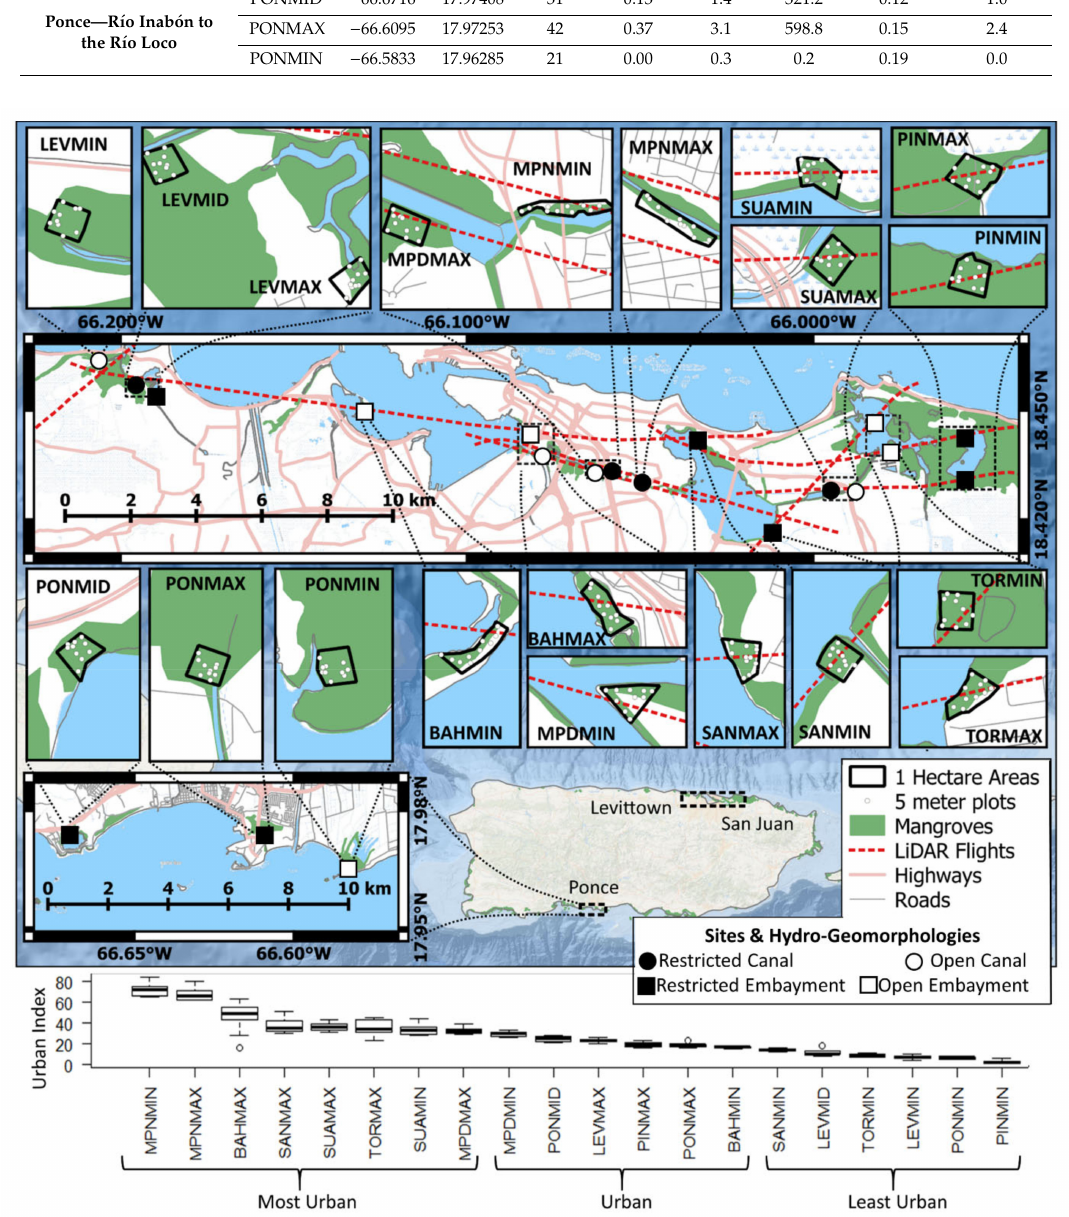
Figure 1. Study sites are twenty 1-hectare mangrove forests in three watersheds (top) and spanning a gradient of urbanization as measured by the urban index (bottom). The urban index is a combination of urban land use, vegetation and open water coverage, population density, and road length. A value of 0 represents the least urban site and a value of 100 is the most urban site. “MAX” and “MIN” postscripts refer to urbanization levels within each water body. BAH is the San Juan Bay, MPN is the Caño Mart í n Peña, SAN is the San Jos é lagoon, SUA is the Suarez canal, TOR is the Torrecilla lagoon, PIN is the Piñones lagoon, LEV is Levittown and PON is